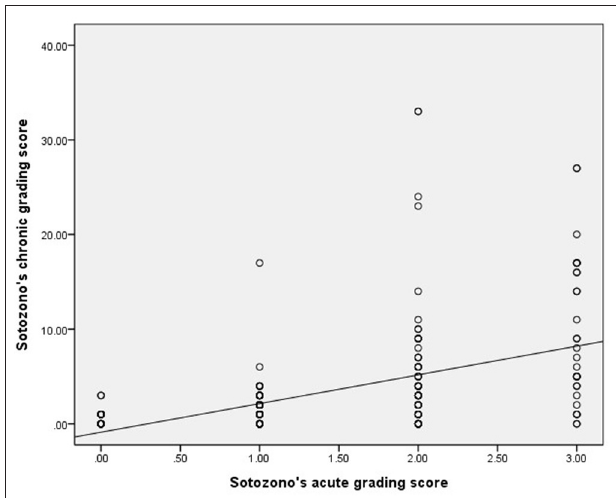
FIGURE 1 | Correlations between Sotozono’s acute (15) and chronic (16) stage grading score of SJS/TEN patients evaluated during the acute and chronic stage, respectively.